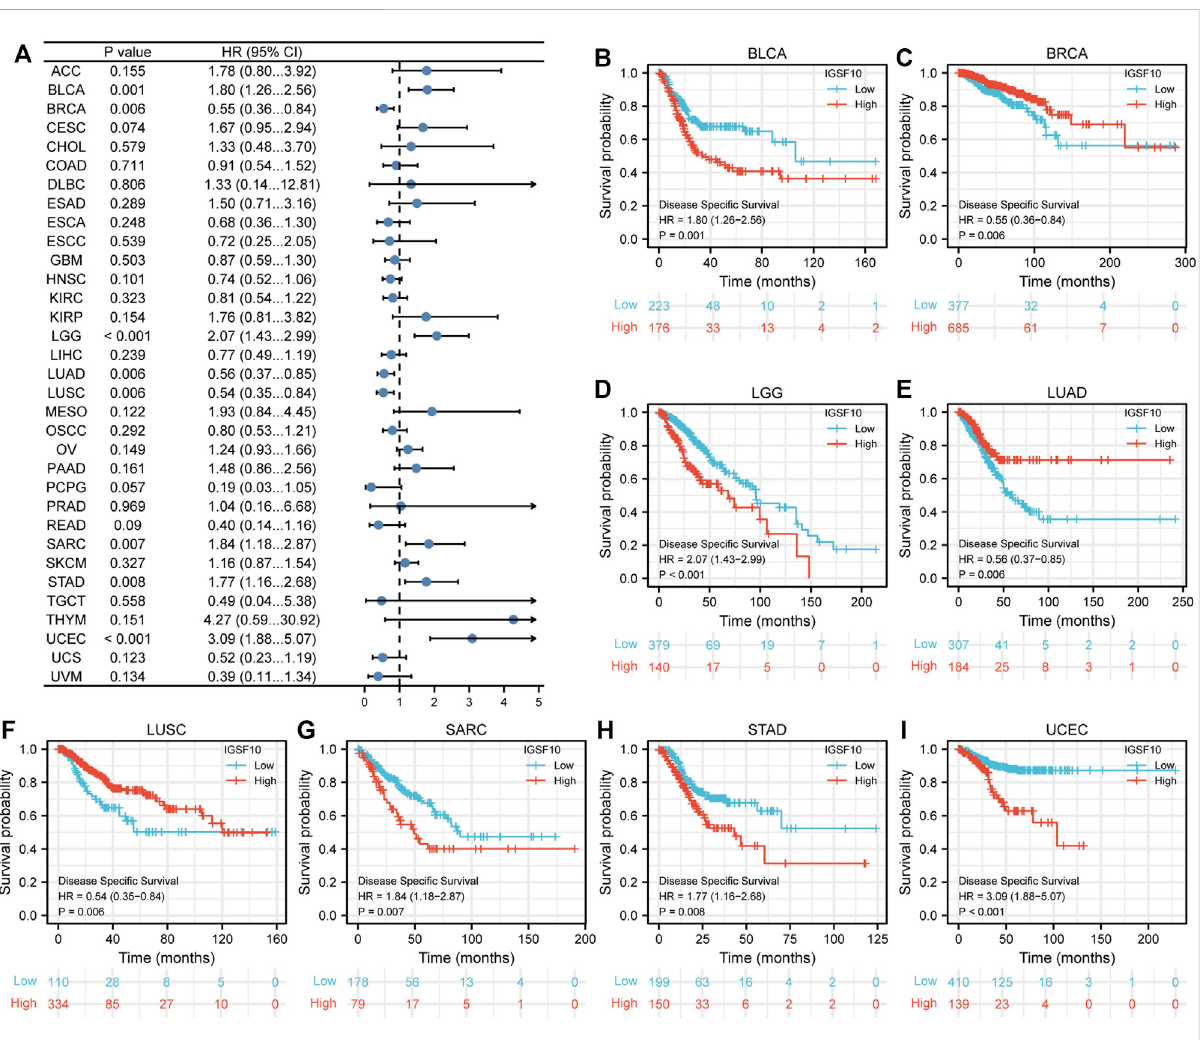
FIGURE 4 Correlations between the IGSF10 expression and disease-speci fi c survival (DSS). (A) Forest plot of results from the univariate survival analysis in pan-cancer for DSS. (B – I) Kaplan-Meier survival curves showed associations between the IGSF10 expression and